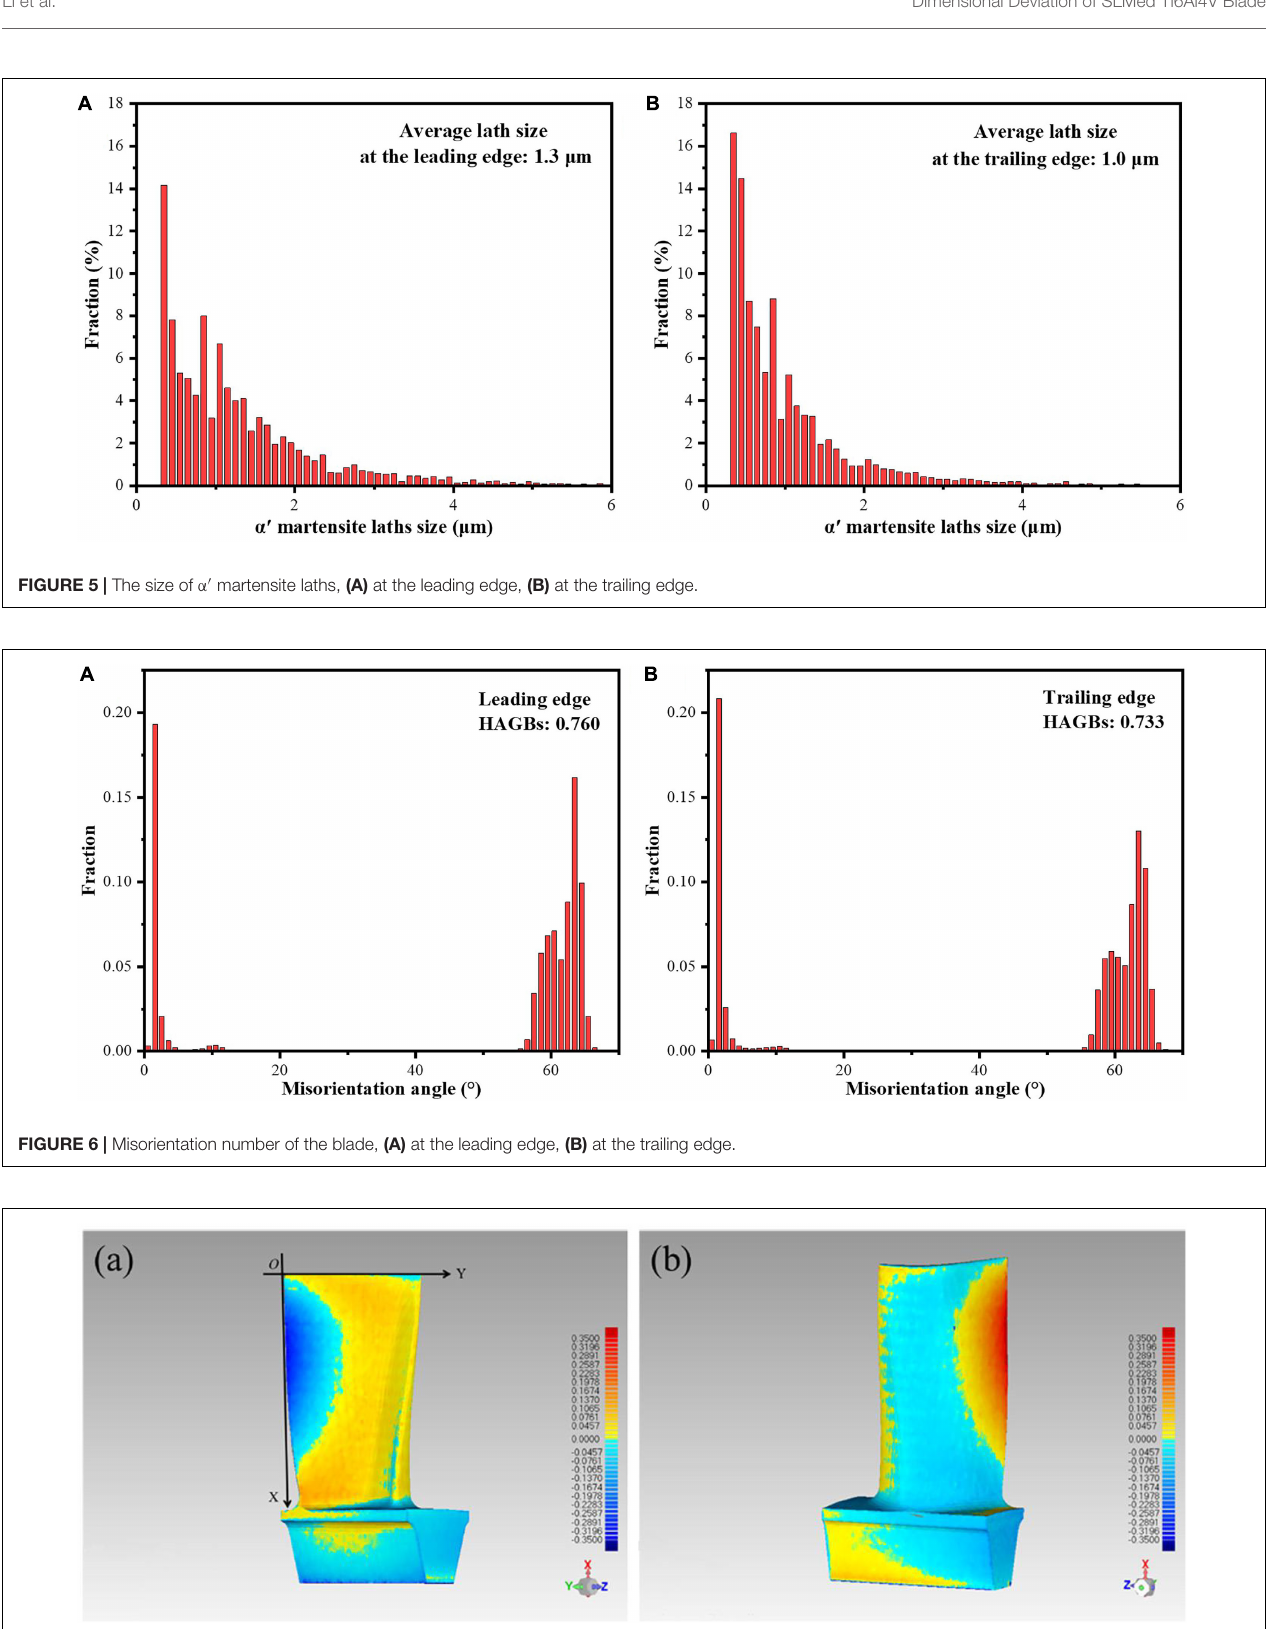
FIGURE 7 | Dimensional deviation of the blade, (a) the pressure surface, (b) the suction surface.